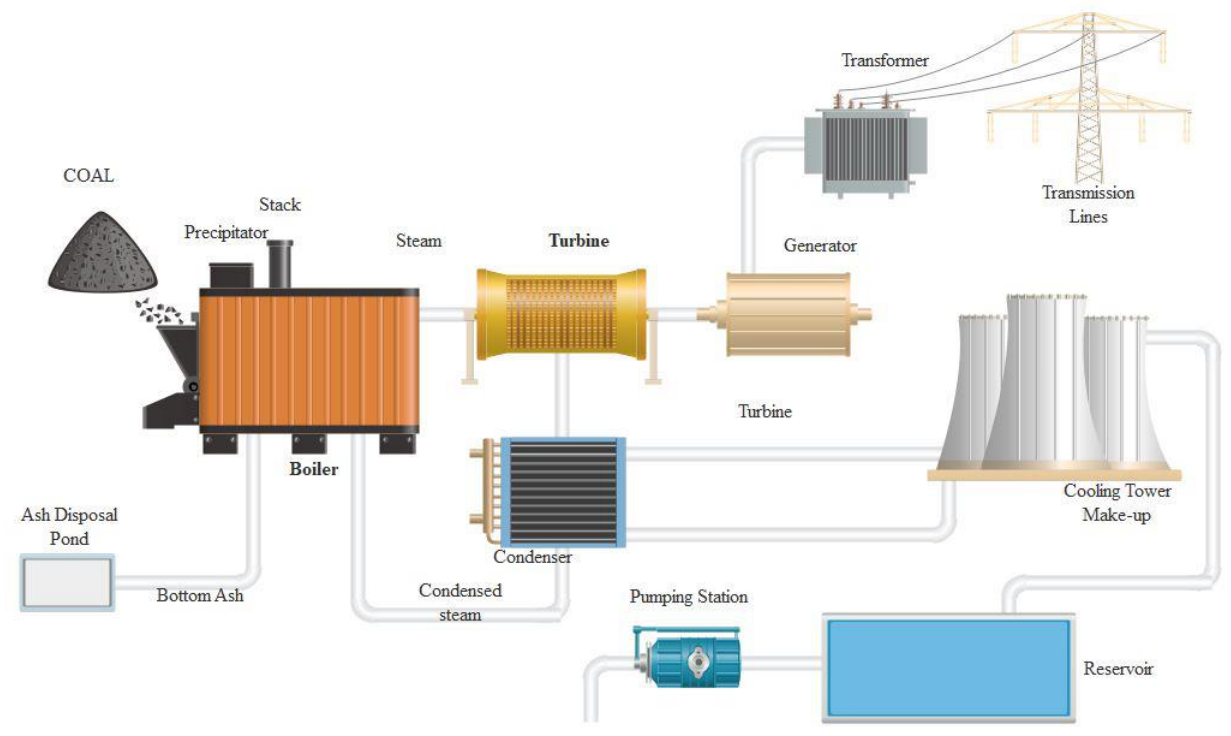
Figure 2. Schematic of the coal-fired TPP representing major equipment